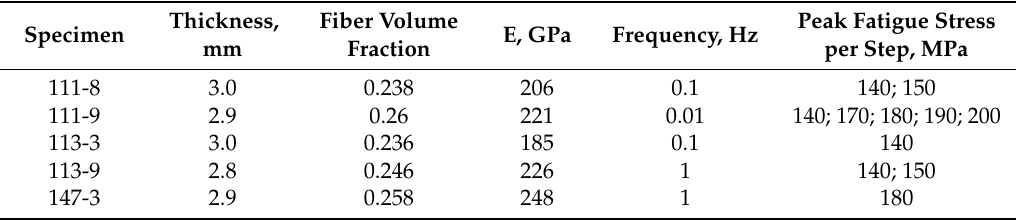
Table 1. Physical and Mechanical Properties of Specimens